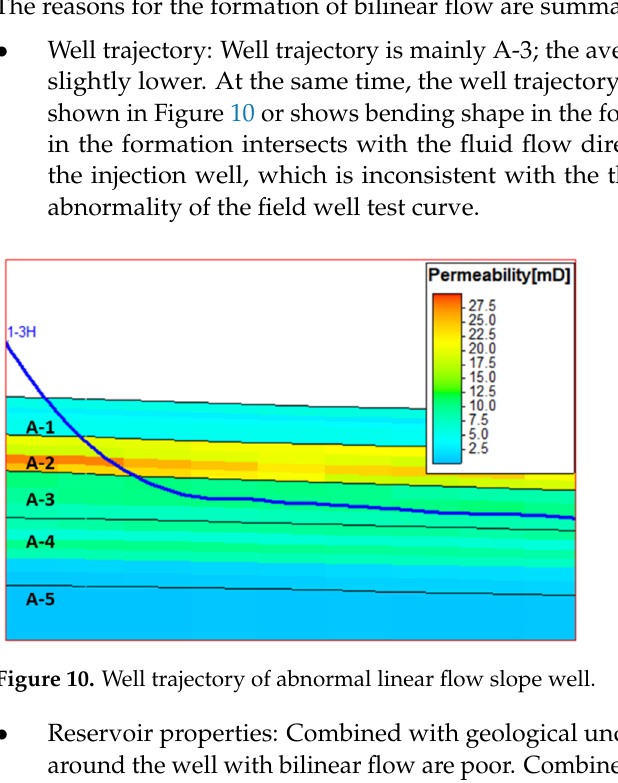
Figure 9. Horizontal well test curve with linear flow slope of 1/3.